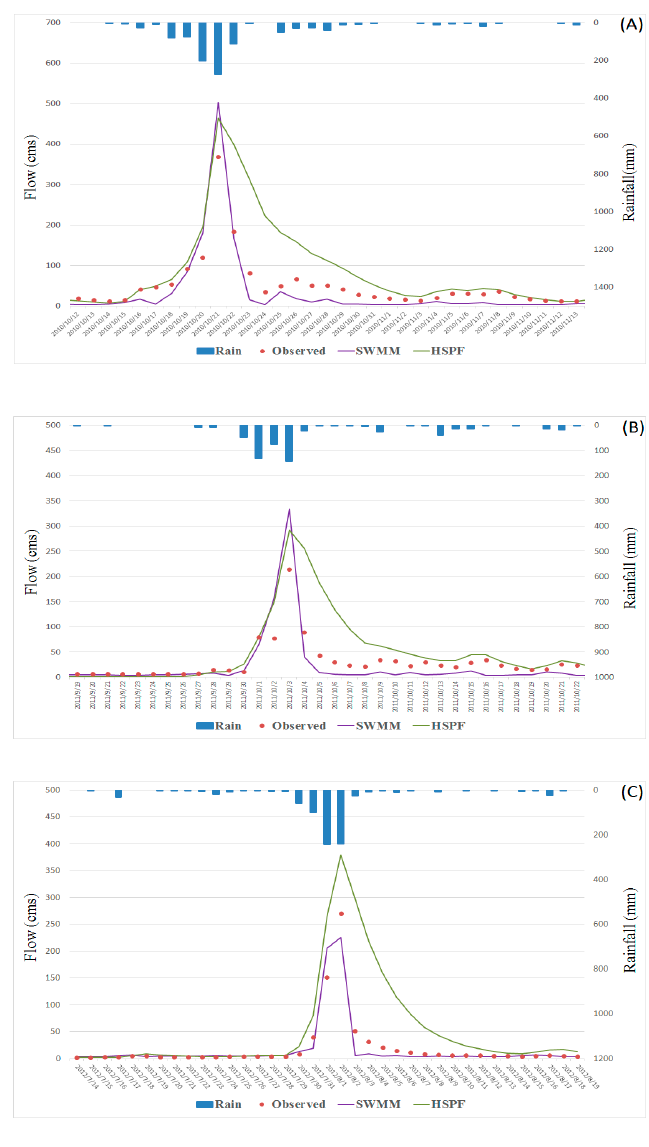
Figure 8. Daily flow simulation results for both models and observations during storm events on ( A